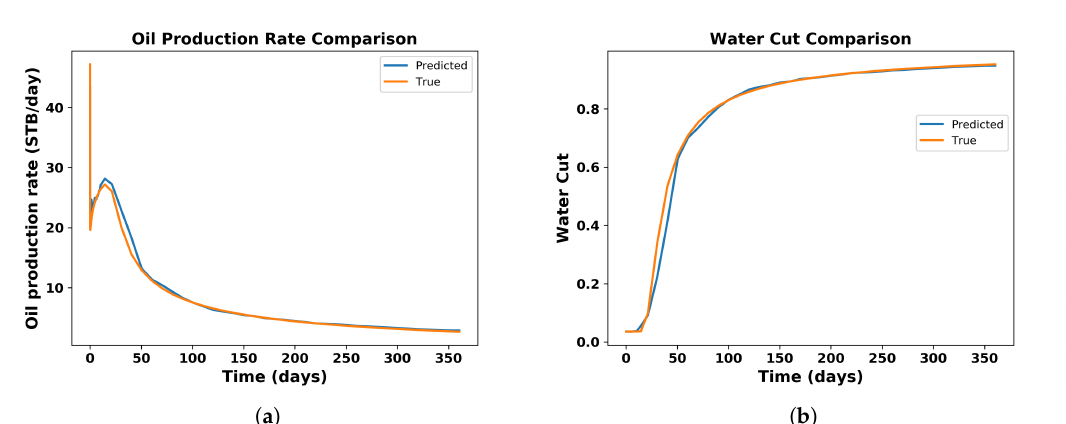
Figure 16. Well block state solution comparison ( a ) Pressure and ( b ) Saturation.